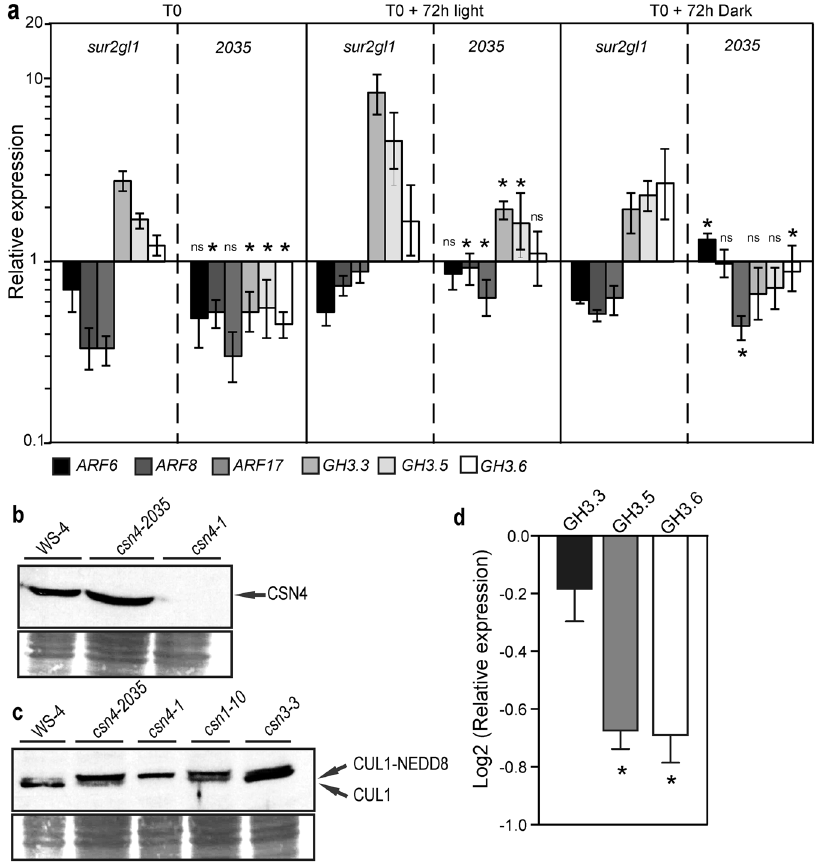
Figure 3. Auxin signaling is perturbed in 2035 . (a) Quantification by quantitative real-time PCR of ARF6 , ARF8 , ARF17 , GH3.3 , GH3.5 and GH3.6 transcript abundance in hypocotyls of sur2-1gl1 and 2035 seedlings, which were etiolated until their hypocotyl had reached 6 mm (T0) and then transferred to the light for 72 h (T0 + 72 h light), or kept in dark for an additional 72 h (T0 + 72 h dark). Gene expression values are relative to the expression in the wild type, for which the value is set to 1. Error bars indicate standard error obtained from three independent biological replicates; ( * ) indicates values that were significantly different from sur2- 1gl1 values according to one-way ANOVA combined with Bonferroni’s comparison post-test; (ns) indicates values not significantly different; ( P < 0.05; n = 3). (b) csn4-2035 is a weak allele mutant that produces as much protein as the wild type. CSN4 western blot analysis of protein extracts prepared from WS-4, csn4-2035 and the null allele csn4-1 . (c) csn4-2035 mutation affects the de-neddylation activity of CSN4 protein. CUL1 western blot analysis of protein extracts prepared from Ws-4 and csn mutant seedlings. The upper band indicates the modified (neddylated) CUL1. Ponceau stained polyvinylidene difluoride (PVDF) membrane is shown as a loading control. ( d ) Quantification by quantitative real-time PCR of GH3.3, GH3.5 and GH3.6 transcript abundance in hypocotyls of csn4-2035 seedlings. Gene expression values are relative to the expression in the wild type, for which the value is set to 1. Error bars indicate standard error obtained from three independent replicates; ( * ) indicate values that were significantly different from wild-type values (P < 0.05; n =